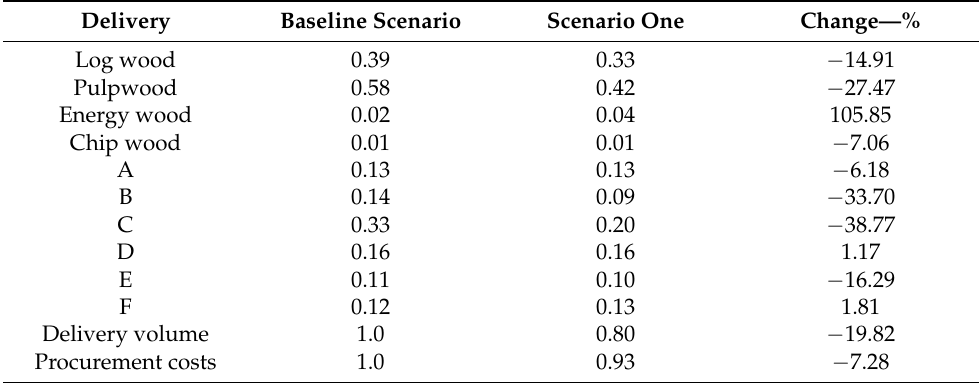
Table 1. Changes in wood deliveries and total costs of wood procurement regions (A–F) in scenario one, “declining export”.